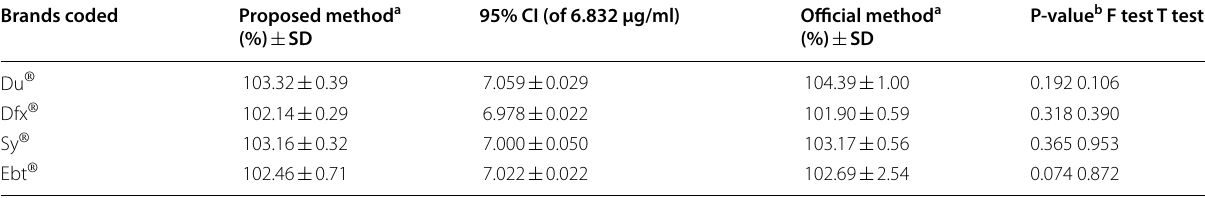
a Mean values, n 6. Content of ceftriaxone stated by USP, 2007 = b Statistical analyses done between the results obtained from the proposed method and the BP official HPLC method